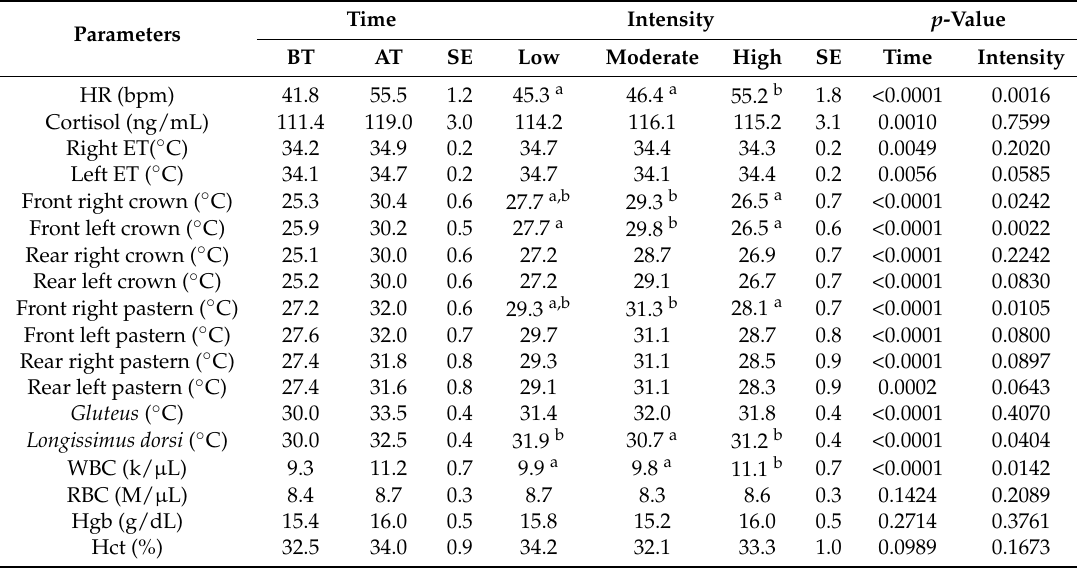
Table 4. Effects of time and intensity on heart rate, serum cortisol level, and smaximal temperature recorded in different points, and white blood cells (WBCs), red blood cells (RBCs), hemoglobin (Hgb), and hematocrit